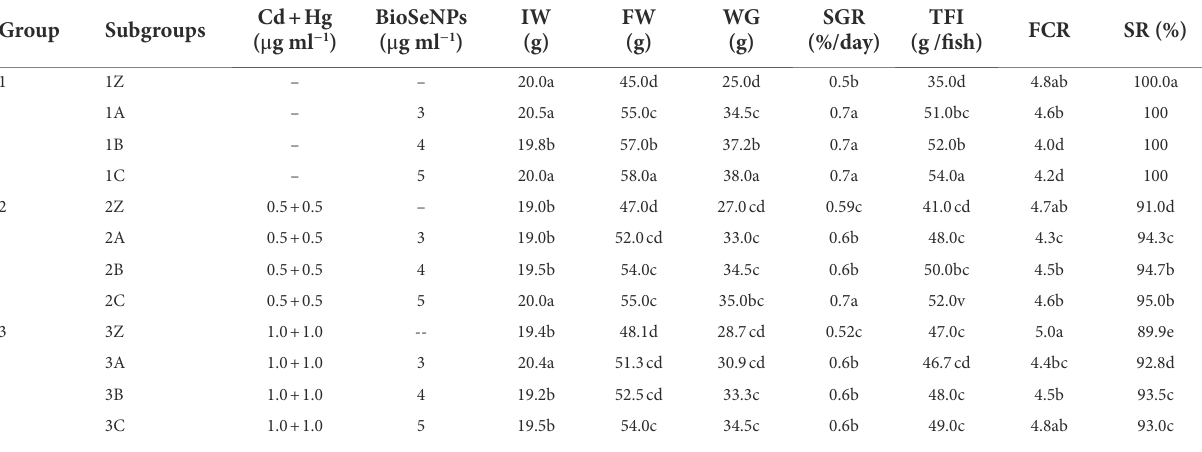
TABLE 2 Growth performance of Nile tilapia ( Oreochromis niloticus ) fish subjected to heavy metals, mercury (Hg) and cadmium (Cd), and treated with biosynthesized selenium nanoparticles (BioSeNPs) during the 10-week experimental period.